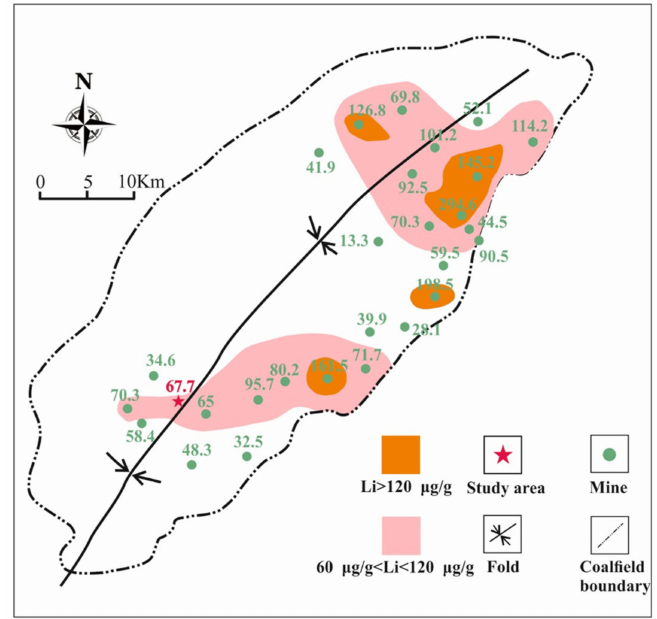
Figure11. ContentmapoflithiumintheDatongcoalfield(thegreennumberrepresentstheconcentration of Li ( µ g / g), data from Yuan et al. [29,35,36], Liu et al. [39], Ma [96], and Shao